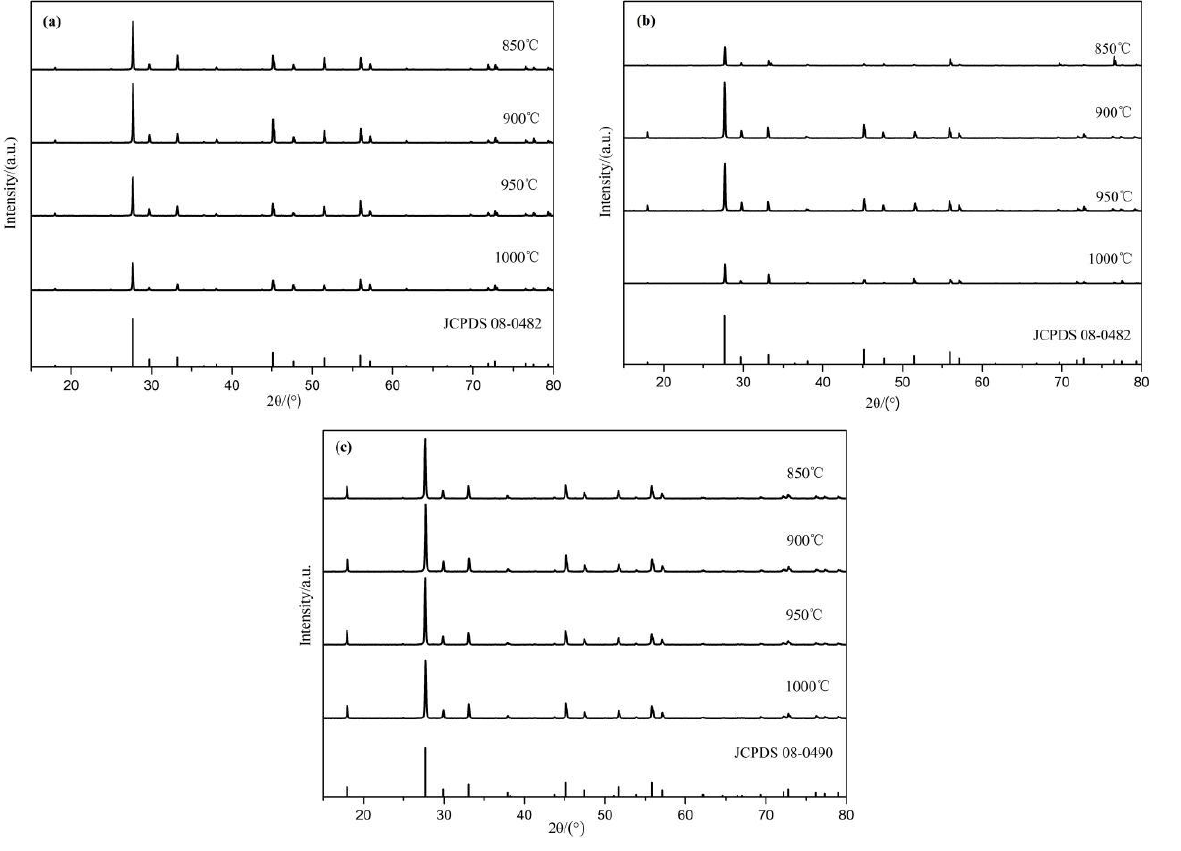
Figure 1. XRD patterns of ( a ) SrMoO 4 , ( b ) SrMo 0.5 W 0.5 O 4 , ( c ) SrWO 4 synthesized at different temper- atures.